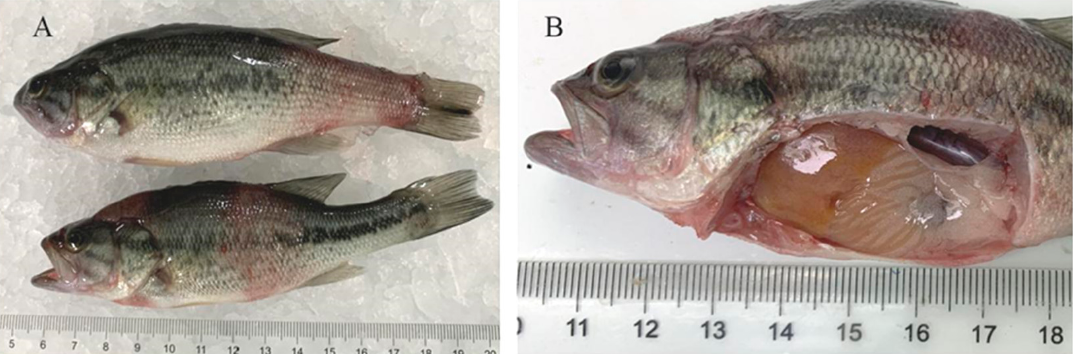
Figure 1. Clinical symptoms of diseased largemouth bass. ( A ) Clinical symptoms of body surface, ( B ) Clinical symptoms of internal organs.